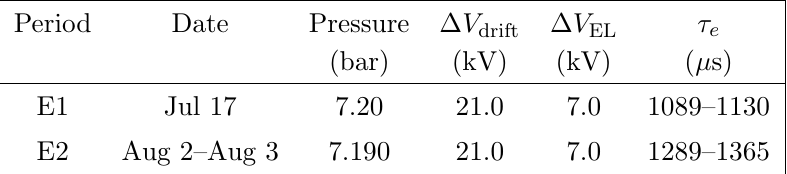
Table 3 . Detector operating conditions for the NEXT-White electron background runs taken during Run-II. The dates refer to the 2017 calendar year. The voltage drops across the drift and EL regions are given by (cid:1) V drift and (cid:1) V EL , respectively. The column (cid:28) e indicates the range of electron lifetimes